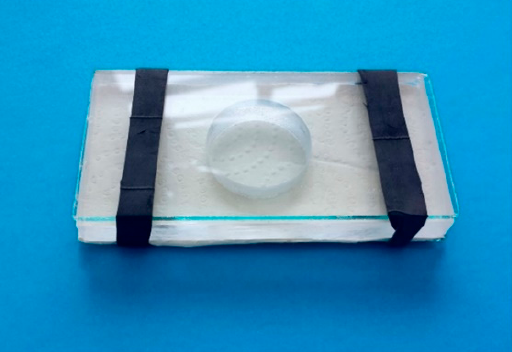
Figure 3. Huffaker cage used in the experiments (Photo by R. Antonelli).